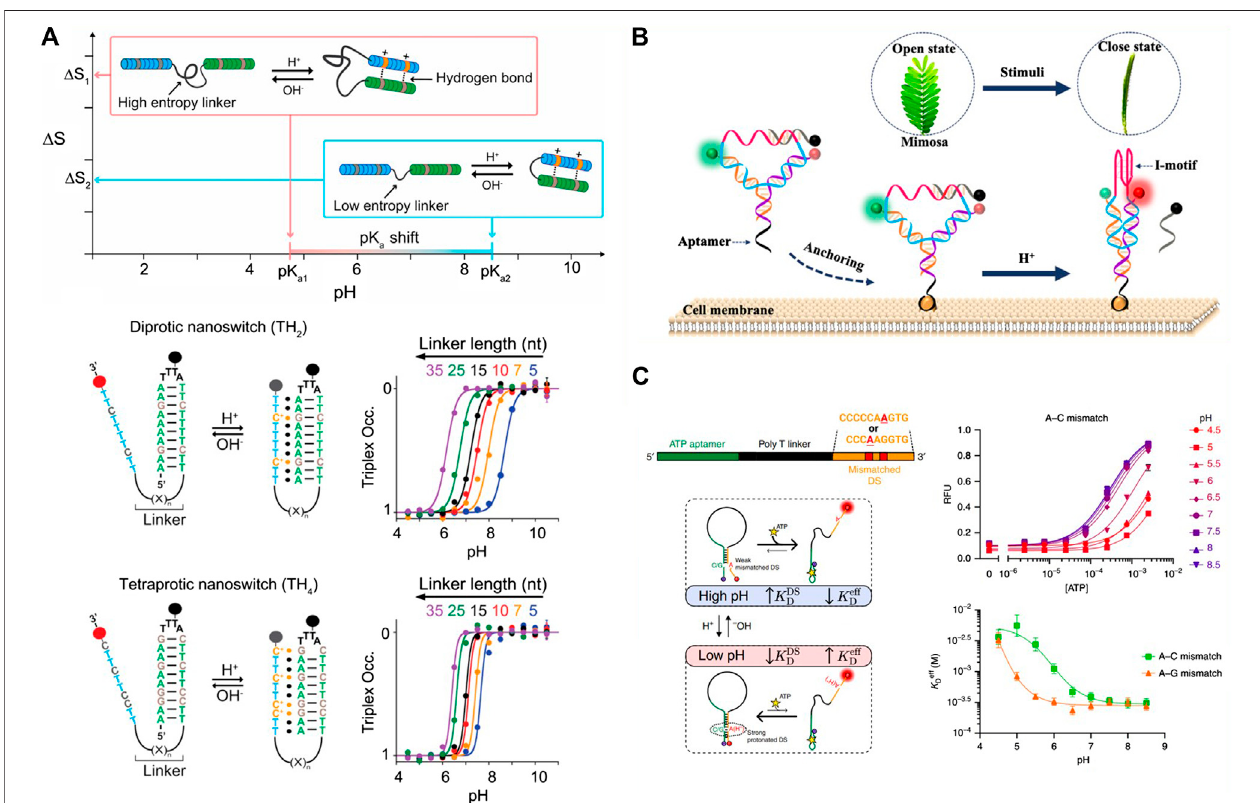
FIGURE 2 | The representative study based on the pH-dependent DNA motif. (A) pH triplex nanoswitches with rationally tailored pK a (Mariottini et al., 2019), reproduced with permission. Copyright 2019, Journal of the American Chemical Society. (B) Y-shaped DNA nanostructure based on the i-motif DNA (Chen B et al., 2020), reproduced with permission. Copyright 2020, ACS. (C) pH-dependent DNA switch containing A + -C mismatch pairs (Thompson et al., 2020), reproduced with permission. Copyright 2020, Springer